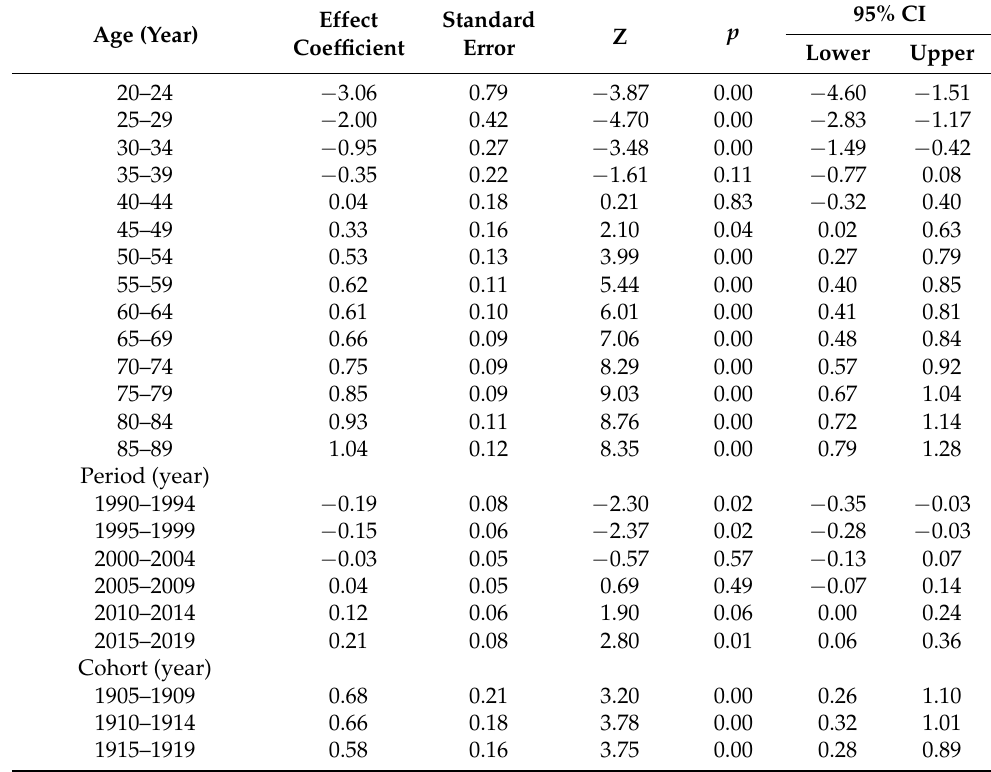
Table 3. Age–period–cohort model of the mortality of breast cancer in Chinese women from 1990 to